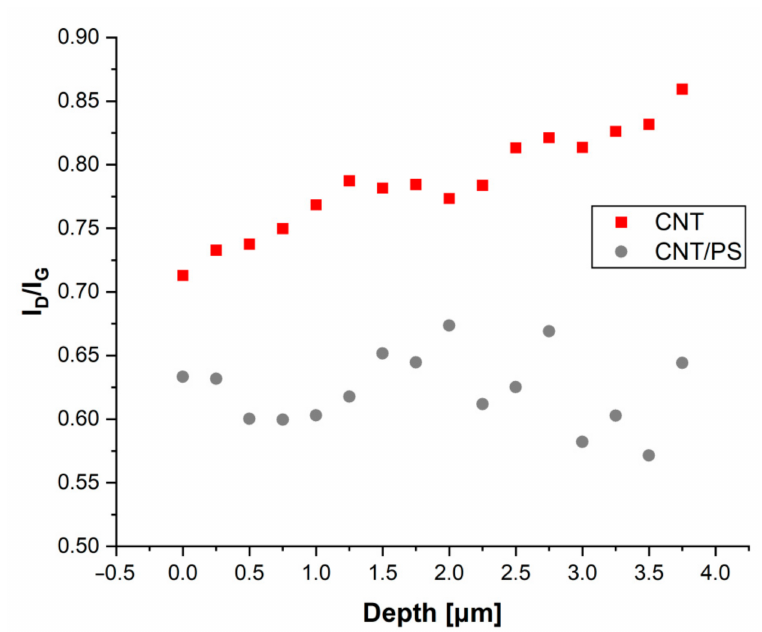
Figure 3. The I D /I G ratio plotted against depth of